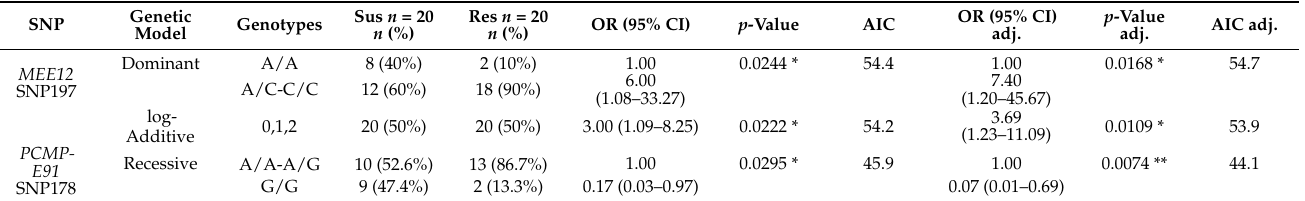
Table 4. Significant association results between genotypes and phenotypes. All analyses were performed with SNPassoc using a logistic regression model.